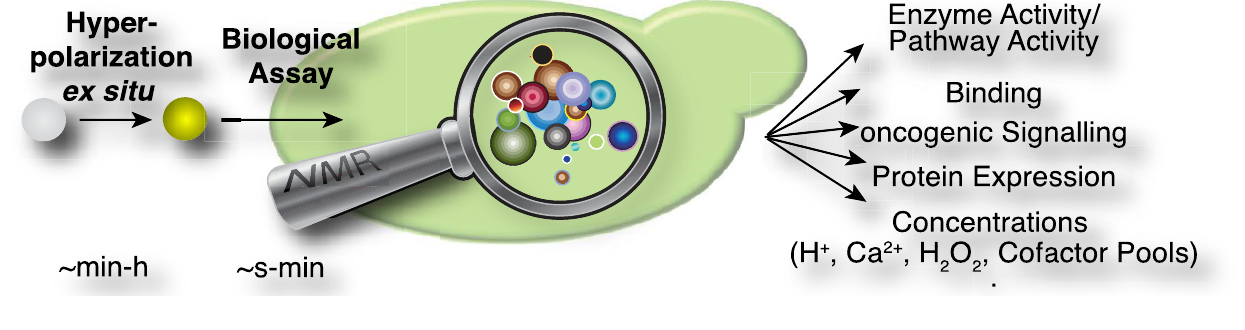
Figure 2. Principle of biological assays using hyperpolarized NMR